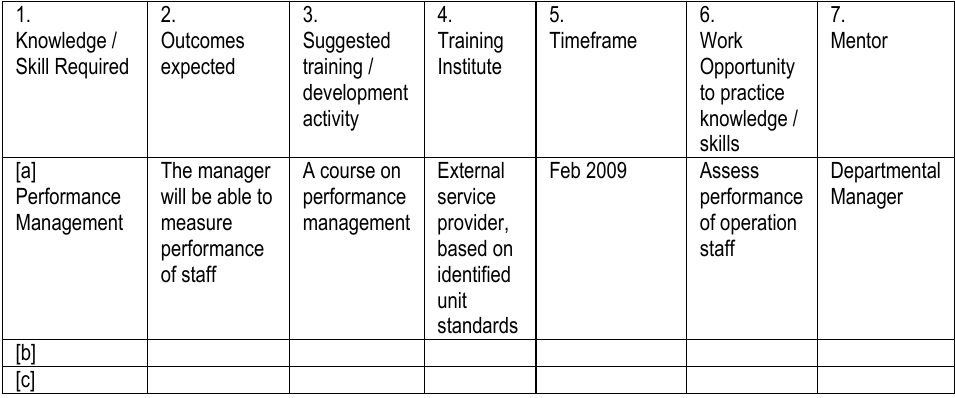
Table 2: Example of a development plan template Personal development plan